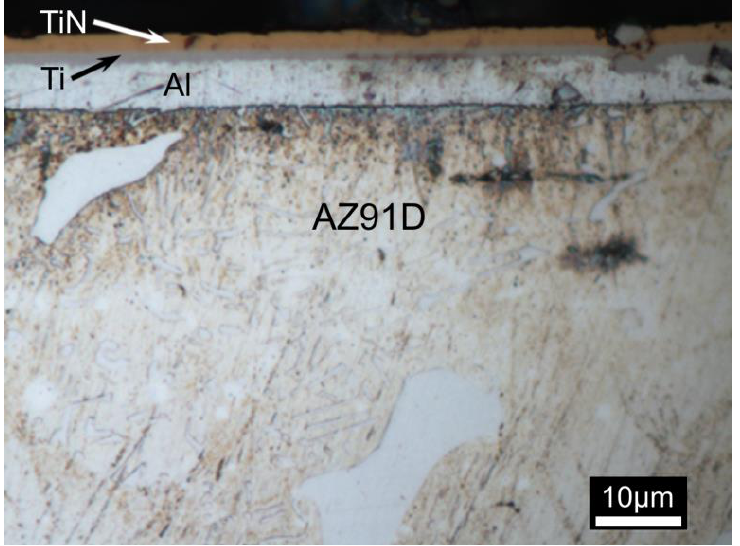
Figure 2. Microstructure of the composite TiN2Ti1Al10-type titanium nitride layer on magnesium AZ91D alloy.